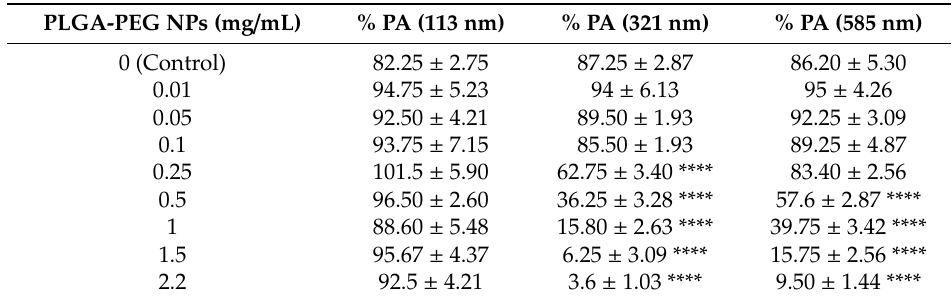
Table 1. E ff ect of size and concentration of Poly-lactide-co-glycolide-polyethylene glycol (PLGA-PEG) nanoparticles (NPs) on percent platelet aggregation (% PA) of platelets in platelet-rich plasma (PRP) following incubation with 20 µ M adenosine diphosphate (ADP) for 12 min.